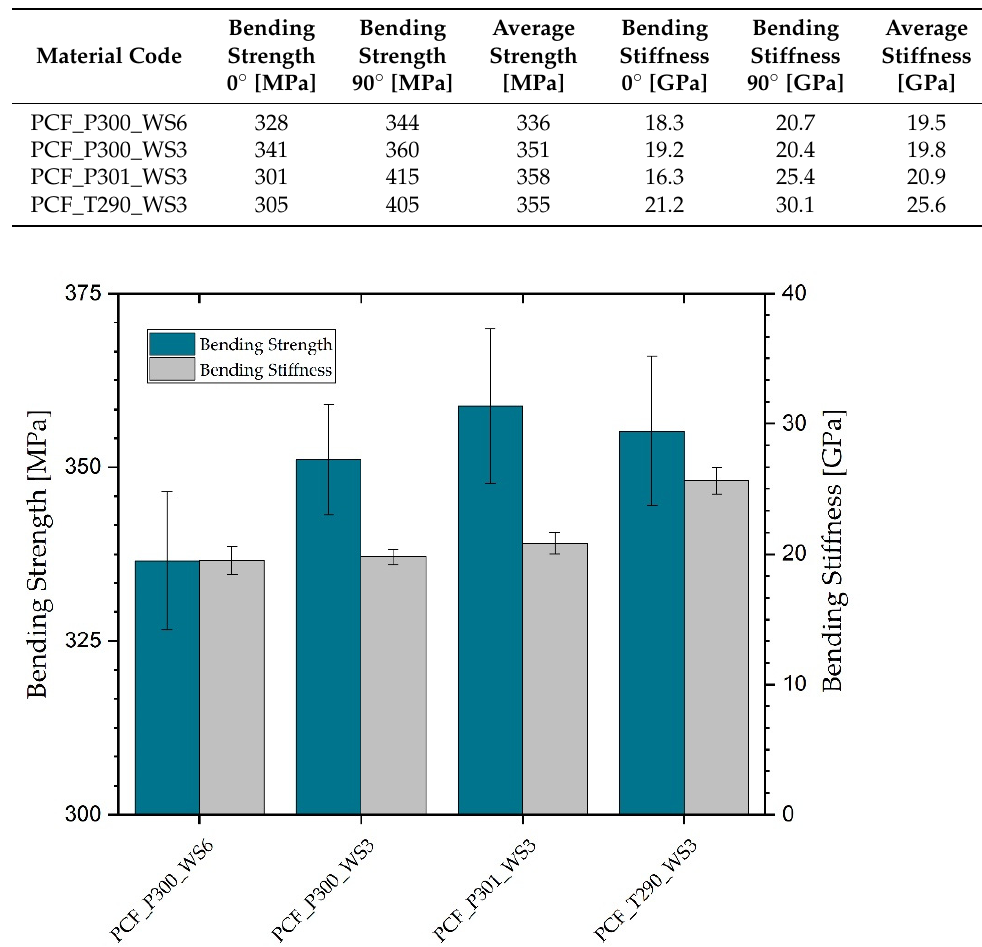
Figure 7. The bending strength and bending stiffness of different machine set-up and different TP fibers. (P300 and P301 are PA6 fibers, and T290 is the PET fiber). WS3 and WS6 equal the number of worker and stripper pairs within the carding line. The FVC of the PA6 materials was scattered between 31% and 33%, and the PET T290 material had an FVC of 30%. The axis of the strength is zoomed in to highlight the effect. The illustrated values are average values of the 0 ◦ and 90 ◦ directions. The PCF_P300_WS6 fiber blend showed